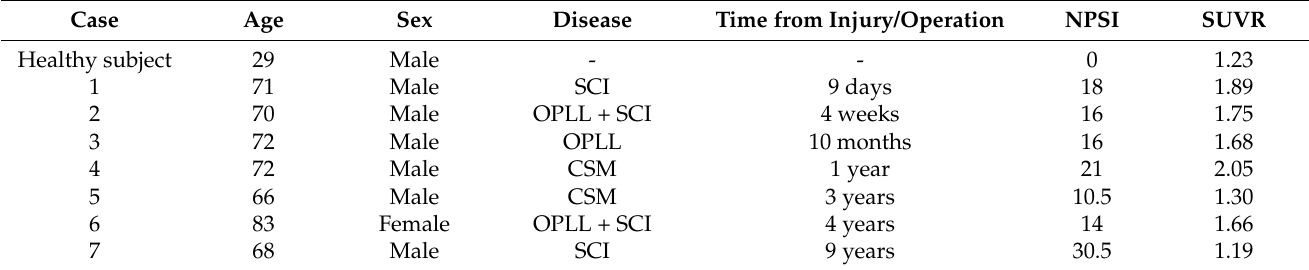
Table 2. Summary of data for (R) -[ 11 C]PK11195 FDG-PET/3T-MRI.